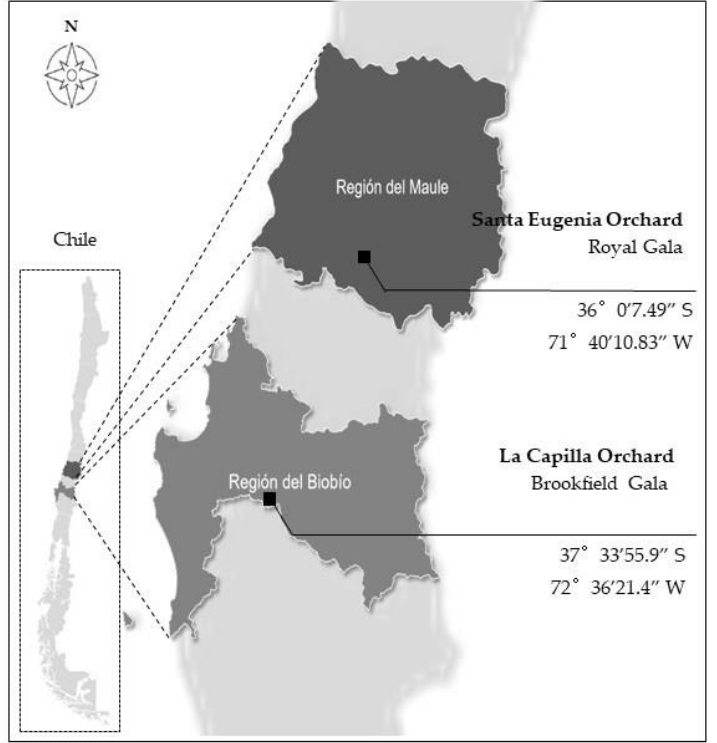
Figure 1. Locations of Santa Eugenia-Orchard (‘Royal Gala’ apple orchard) and La Capilla-Orchard (‘Brookfield Gala’ apple orchard).